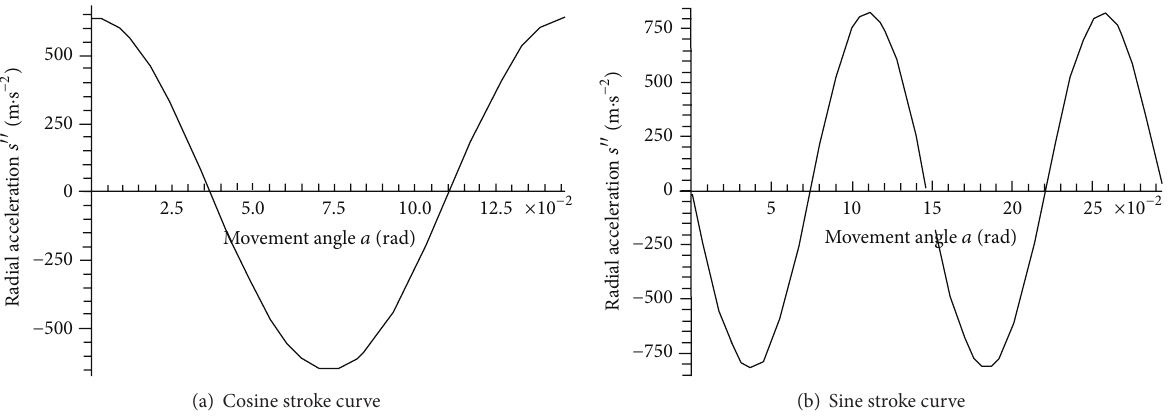
Figure 2: The radial acceleration curve of cropping hammer in different stroke curve.